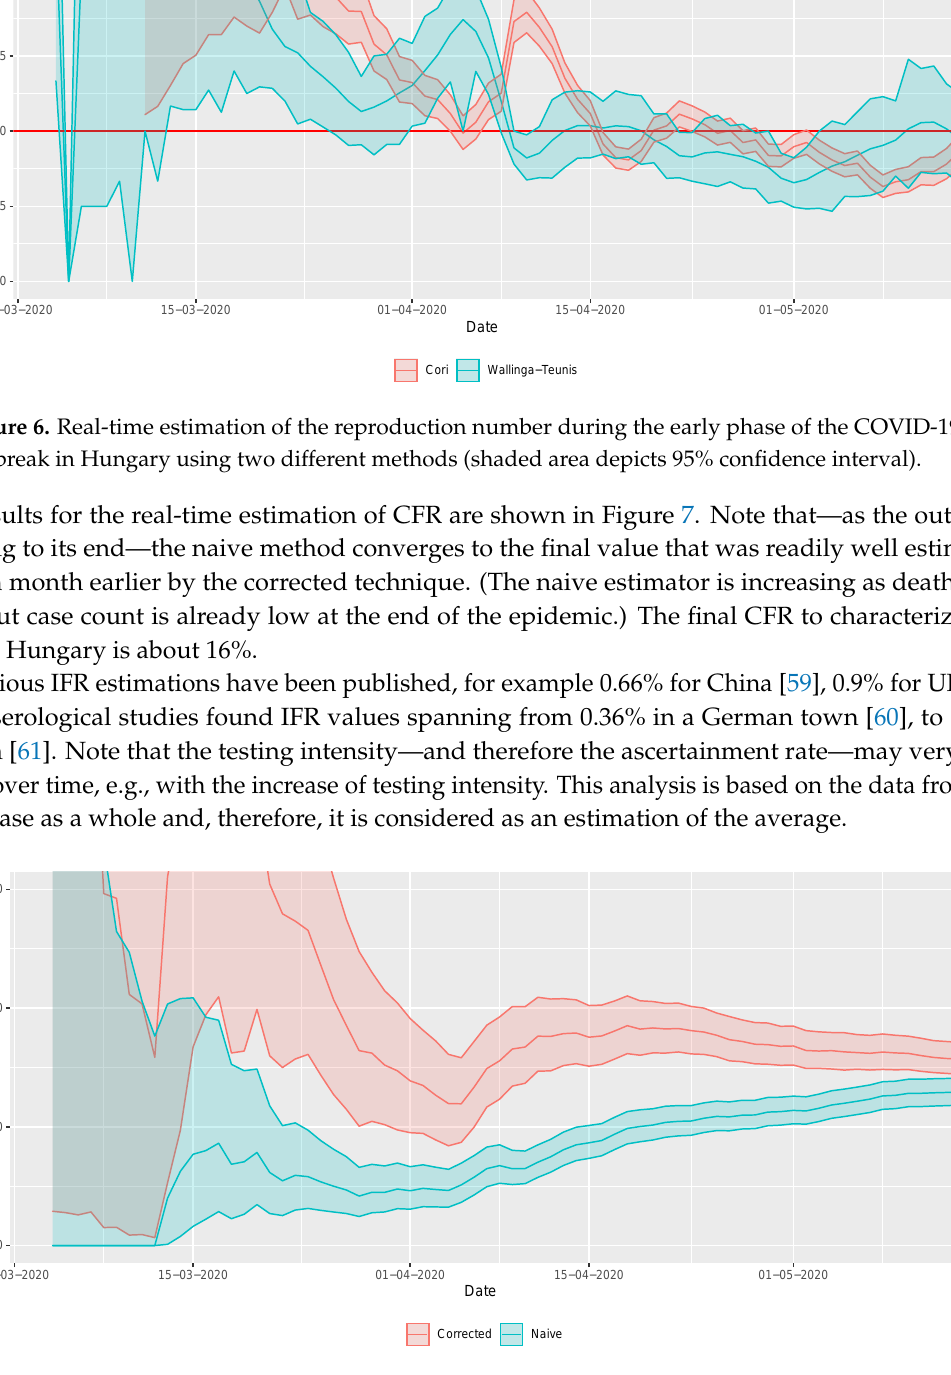
Figure 7. Real-time estimation of case fatality rate during the early phase of the COVID-19 outbreak in Hungary (shaded area depicts 95% confidence